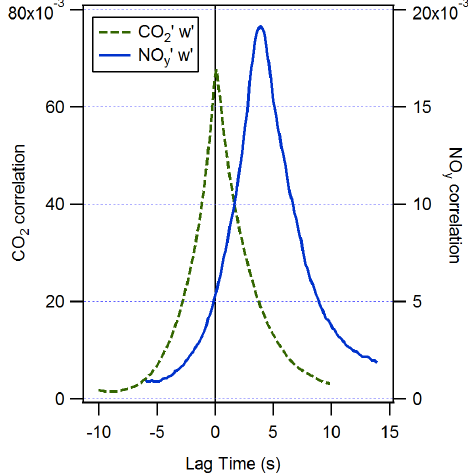
Fig. 2. Average lagged correlation plot to determine the true lag between NO y sensor response and vertical wind ( w 0 ) observations. Also shown is the lagged correlation plot for w 0 CO 2 0